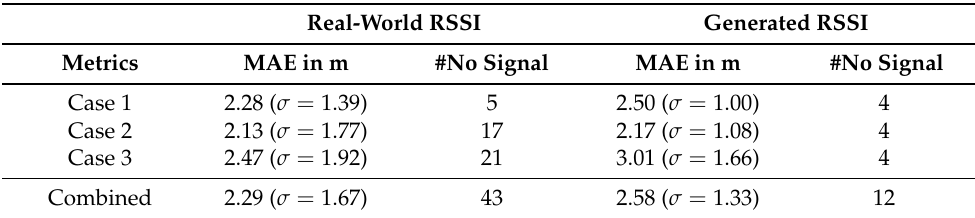
Table 5. Real- world experiment—location prediction performance.